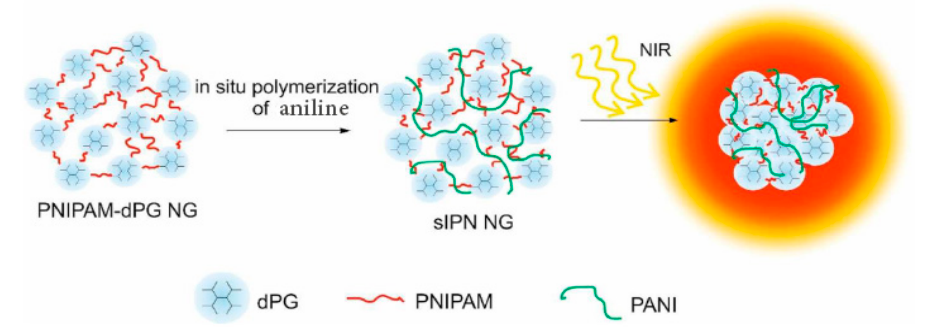
Figure 4. In-situ mechanism for near-infrared absorbing nanogels based on PNIPAM-dPG-PANI for Figure 4. In ‐ situ mechanism for near ‐ infrared absorbing nanogels based on PNIPAM ‐ dPG ‐ PANI for photothermal cancer therapy. Adapted from Ref. [79] reproduced by permission of The Royal Society photothermal cancer therapy . Adapted from Ref. [80] reproduced by permission of The Royal Society of of Chemistry.